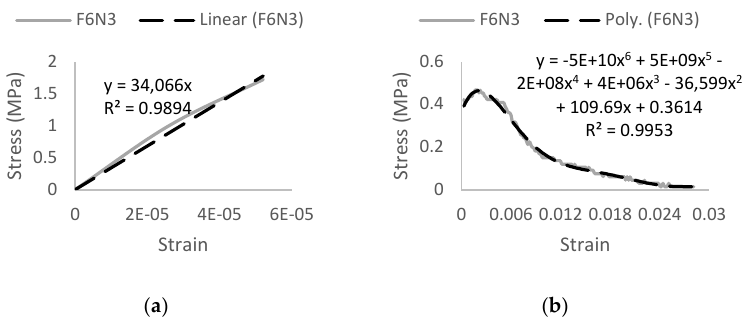
Figure 11. F6N3 uniaxial tension stress – strain curve: ( a ) elastic stage and ( b ) plastic stage. Table 11. Material properties of F6N3